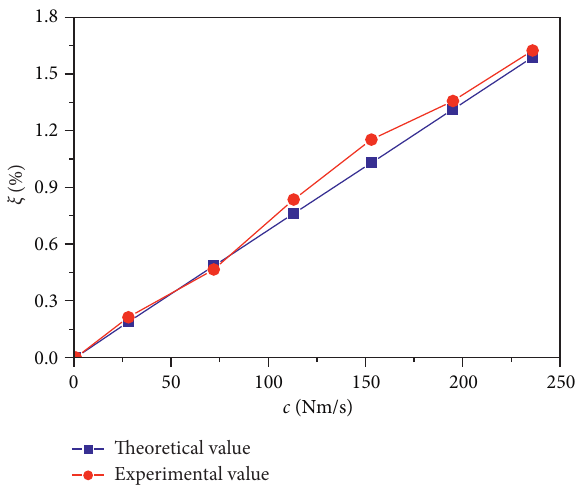
Figure 4: Additional damping ratio of experimental value and theoretical value.